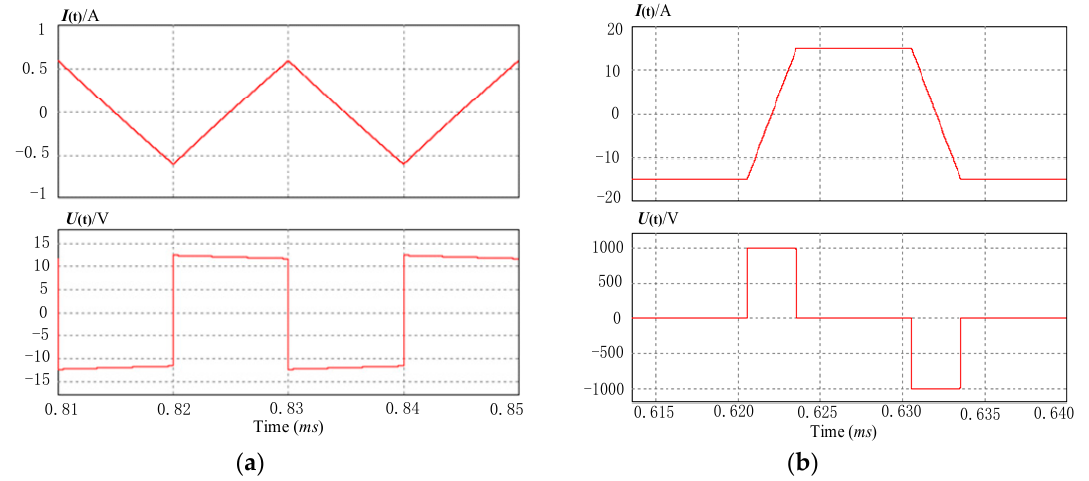
Figure 9. Waveforms of the output current and voltage, 50 KHz. ( a ) Traditional full-bridge circuit, ( b ) Constant current and voltage clamping control circuit.